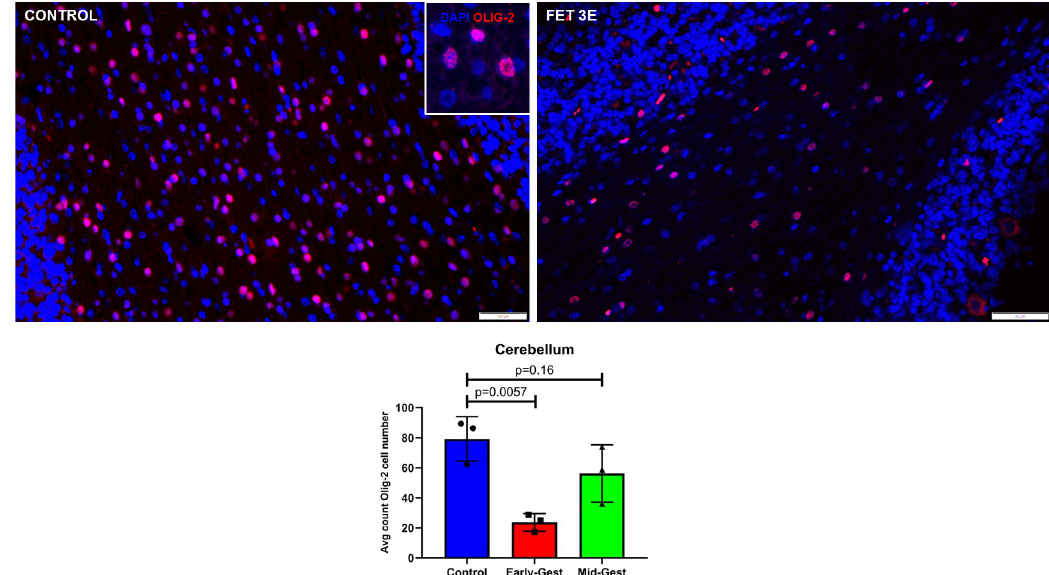
Fig 9. Immunofluorescence (IF) for Olig-2 (oligodendrocyte precursor) in the granular layer of the cerebellum. In the control cerebellum, numerous Olig-2+ cells (arrow, inset) could be seen in the granular layer whereas in fetal cerebellum from early- gestation ZIKV inoculated dams, significant decrease in Olig-2+ cell population were noted. However, fetal cerebellum from mid- gestation ZIKV inoculation dams did not show difference in Olig-2+ cell population compared to the control. (Scale bar = 100 μ m (control), 20 μ m (Fet 3E); Error bars depict SD, Dunnett’s multiple comparison test was done for statistical analysis, p < 0.05 considered significant).